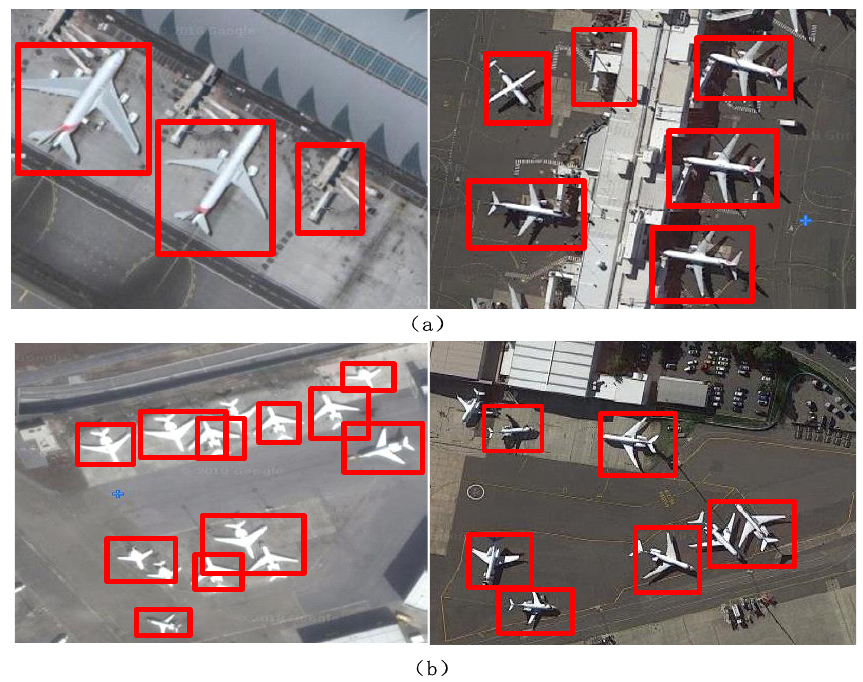
Figure 7. Various airplane detection failures. ( a ) some regions were misidentified as airplanes; ( b ) many airplanes were not determined to be airplanes.